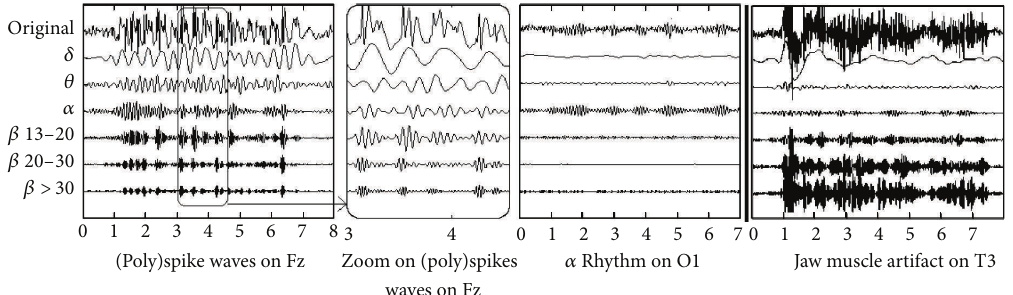
Figure 1: Frequency decomposition of cerebral rhythms and muscle artifacts